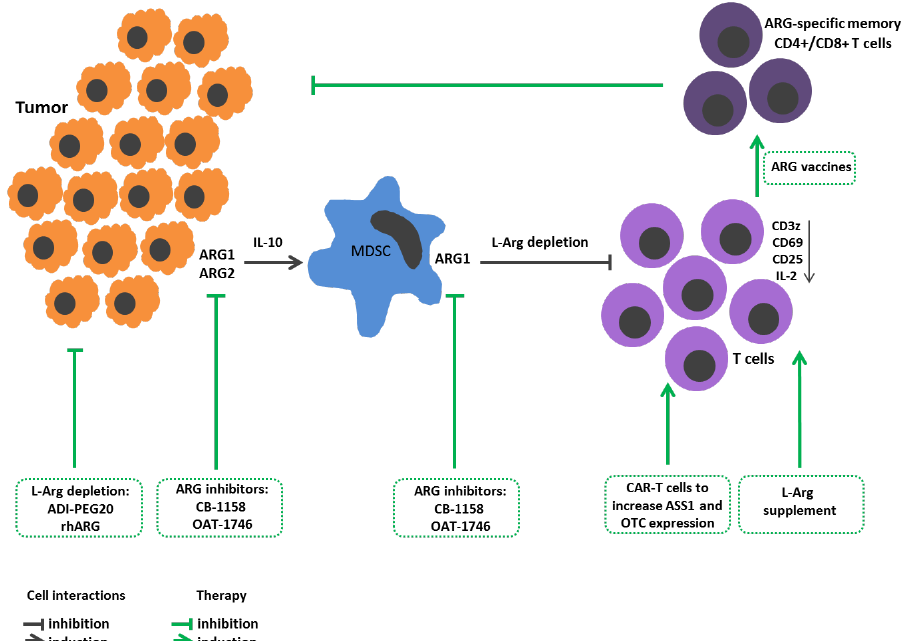
Figure 1. L-Arginine metabolism in tumor growth immunopathogenesis and arginine-dependent processes as a target of therapeutic approaches. Expression of arginases by tumor cells promotes their proliferation and metastasis. Arginase-mediated depletion of L-Arg in the tumor microenvi- ronment contributes to the development of immunosuppression. Tumors also induce arginase in the microenvironment. Tumor-infiltrating arginase-expressing MDSC metabolites stimulate tumor mutagenesis, reinforce immunosuppression, decrease CD3z, CD25, CD69 expressions in T cells and IL-2 production. Therapeutic strategies: Arginine-hydrolyzing enzymes result in L-Arg exhaustion in tumor microenviroment and inhibit tumor cell proliferation. Administration of ARG inhibitors decreases tumor growth/metastasis. L-Arg supplement restores T cell functions. Reengineering CAR-T cells increases ASS1 and OTC expression to improve T cell L-arg bioavailability. Elaboration ARG1-specific CD4+ and CD8+ T cell promotes arginase-positive cell elimination. ADI-PEG20, pegylated arginine deiminase; ARG1, arginase 1; ARG2, arginase 2; ASS1, argininosuccinate